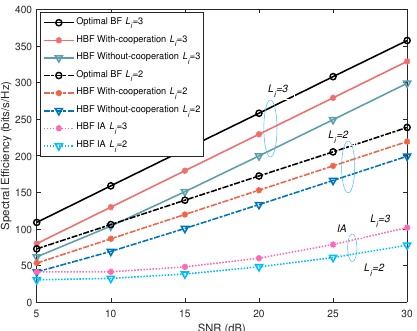
Figure 4. Effective system sum rate versus SNR.